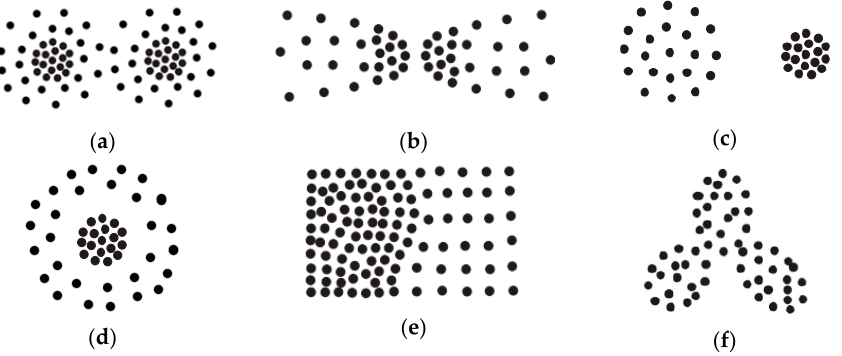
Figure 1. Examples of representative spatial patterns. ( a – f ) Spatial patterns include clusters with different shapes, sizes and